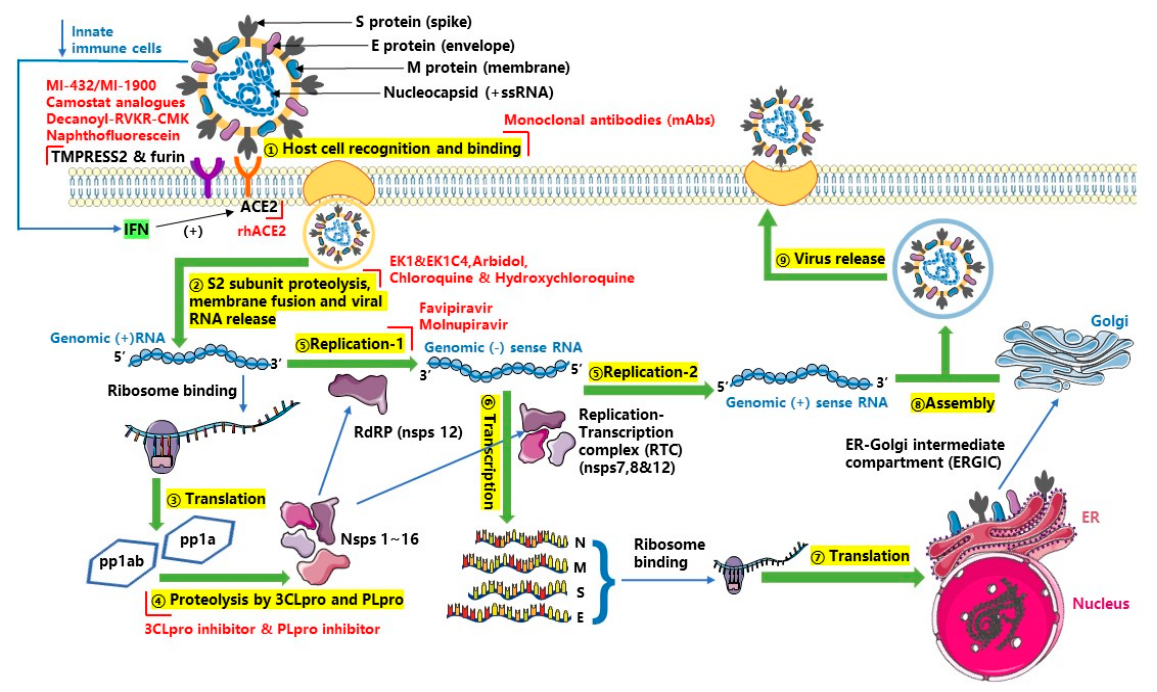
Figure 2. Replication cycle of SARS-CoV-2 in host cells, and targets for antiviral drugs and compounds which are marked with red “ ∟ ” symbols.